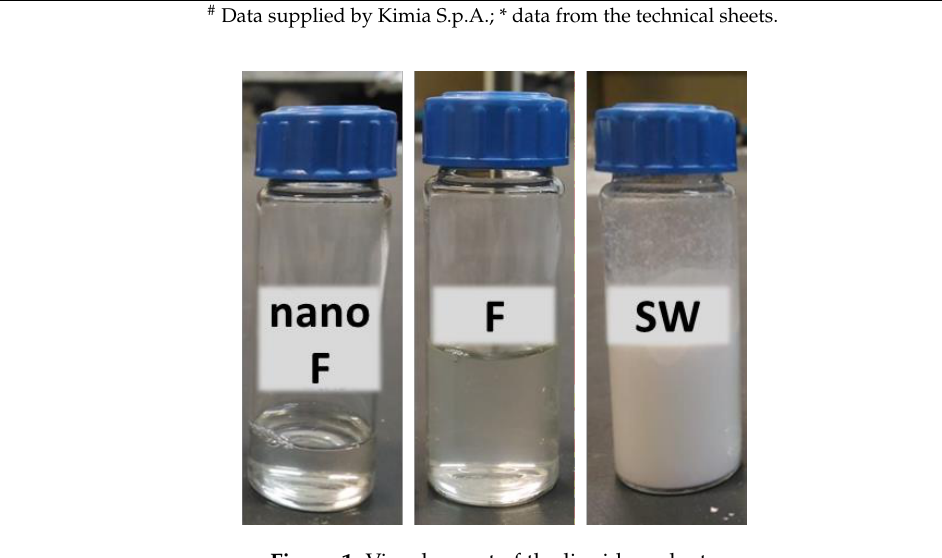
Figure 1. Visual aspect of the liquid products.